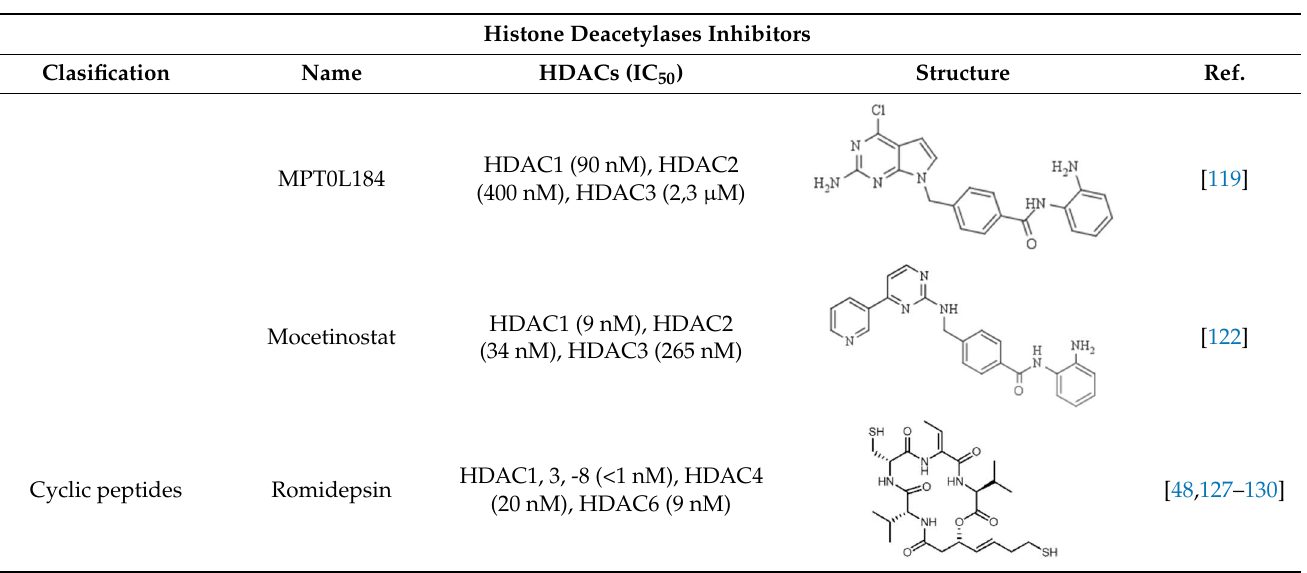
Table 2. Cont. Histone Deacetylases